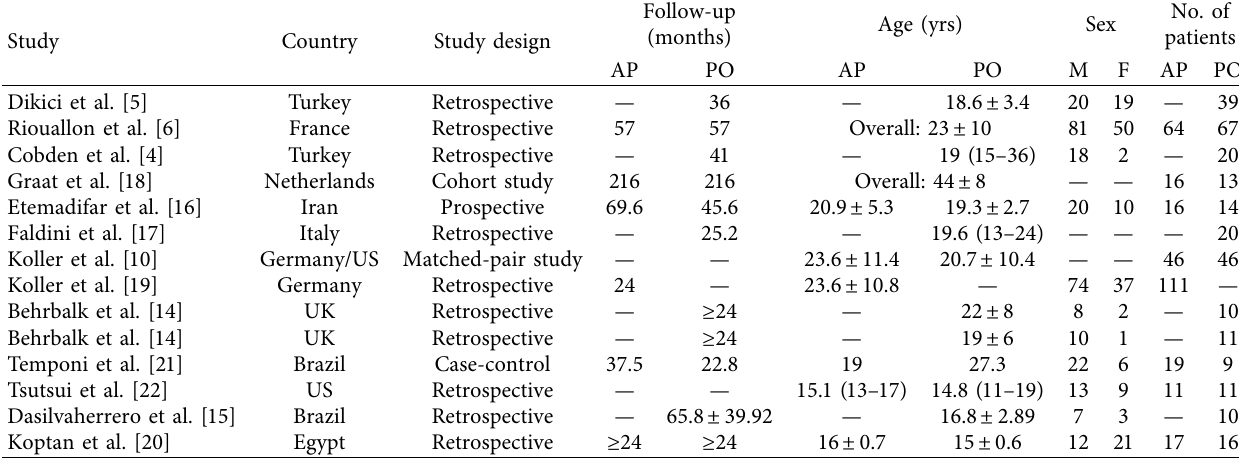
Table 2: Characteristics of included studies.